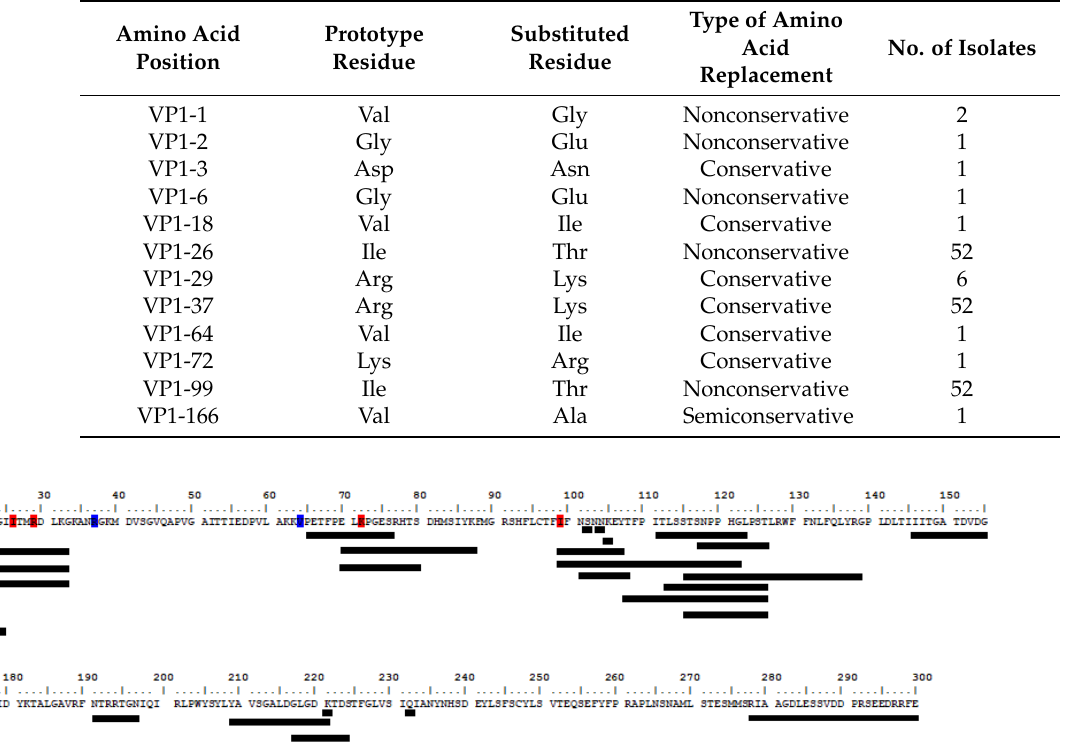
Figure 4. Amino acid replacements localization compared to reference strain and position within the experimentally B/Tcell epitopes regions [12,37,38,40,41,45]. Replacements located in epitope region are indicated in red. Replacements located close to epitope region are indicated in